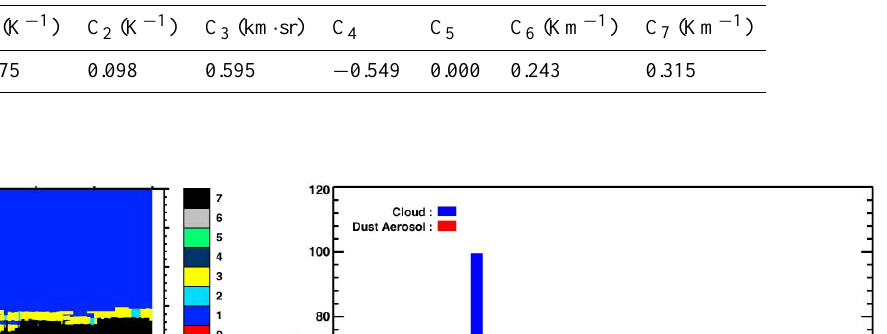
Table 3. Coefficients in Eq. (3).